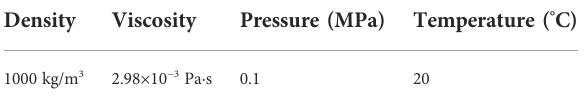
TABLE 1 Experimental parameters of fl ow maldistribution in the horizontal